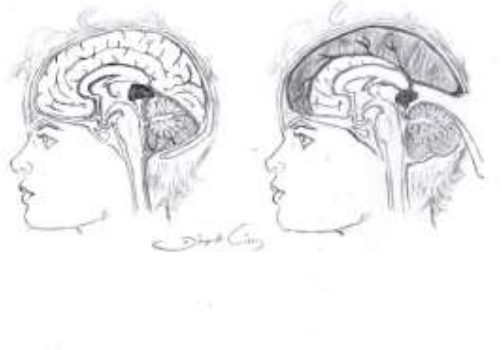
Figure 4. A supracerebellar and infratentorial approach. A generous exposure of the pineal region through a "cross-court" midline or oblique trajectory, while avoiding excessive retraction on the